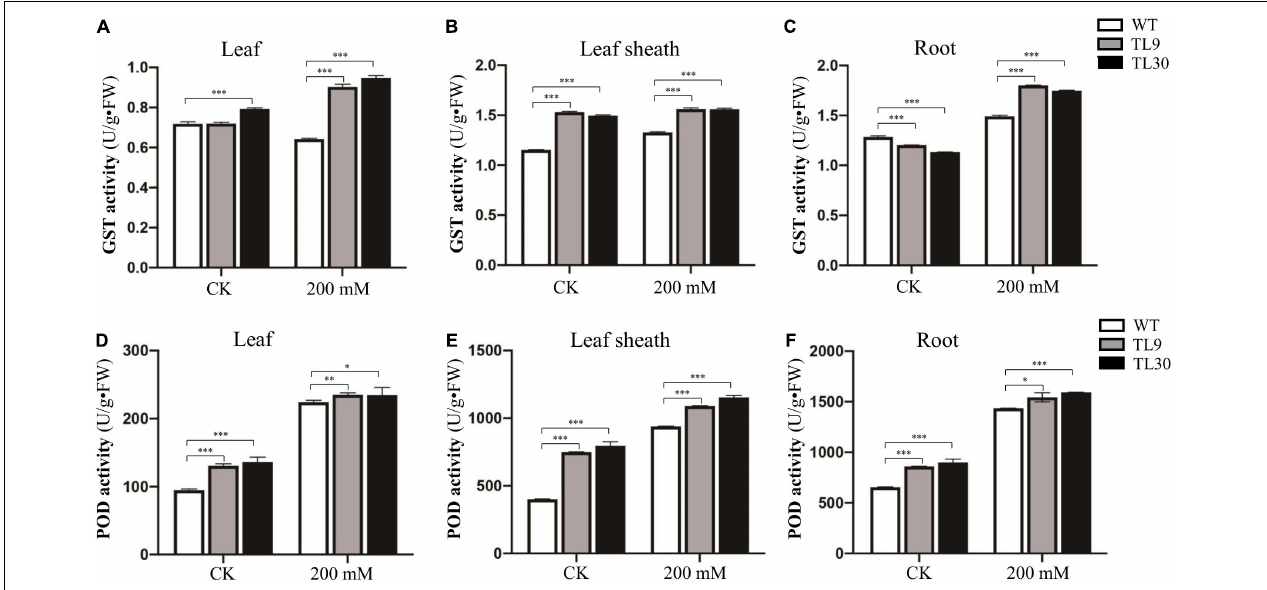
FIGURE 3 | Antioxidant enzyme activity analysis in the different tissues of transgenic wheat lines and WT plants under salt stress and normal growth conditions. The GST activity in leaves (A) , leaf sheaths (B) , and roots (C) , and the POD activity in leaves (D) , leaf sheaths (E) , and roots (F) are shown in the Figure. TL9 and TL30, the transgenic wheat lines; WT, wild type. Mean values and deviations were calculated from three independent biological experiments. ∗ p ≤ 0.05, ∗∗ p ≤ 0.01, and ∗∗∗ p ≤ 0.001 indicate significance in transgenic wheat lines relative to WT.